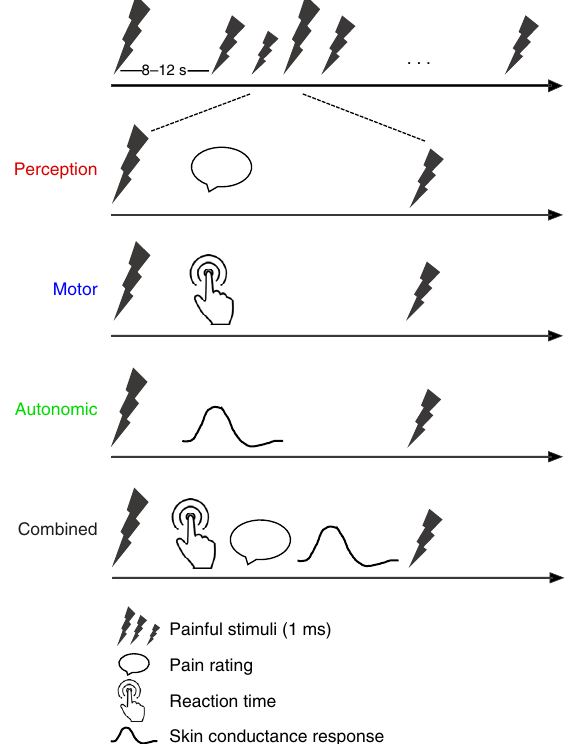
Fig. 1 Paradigm. The paradigm comprised three core conditions (perception, motor, and autonomic) and an additional combined condition, which were presented in pseudorandomized order. In each condition, 60 painful laser stimuli were applied to the dorsum of the left hand. Stimulus intensity was varied in a pseudorandomized sequence between three individually adjusted levels (low, medium, and high). The interstimulus interval was varied between 8 and 12 s. In the perception condition, participants were prompted to verbally rate the perceived pain intensity on a numerical rating scale (0 – 100). Pain ratings served as a measure of the perceptual dimension of pain. In the motor condition, participants were instructed to release a button pressed with the index fi nger of the right hand as fast as possible in response to noxious stimuli. Reaction times served as a measure of the motor dimension of pain. In the autonomic condition, participants were instructed to focus on the painful stimulation without any particular task while skin conductance responses (SCRs) were recorded. SCRs served as a measure of the autonomic dimension of pain. In the combined condition, the participants were asked to fi rst release the button as fast as possible in response to the noxious stimulus and then provide a pain rating. In addition, SCRs were